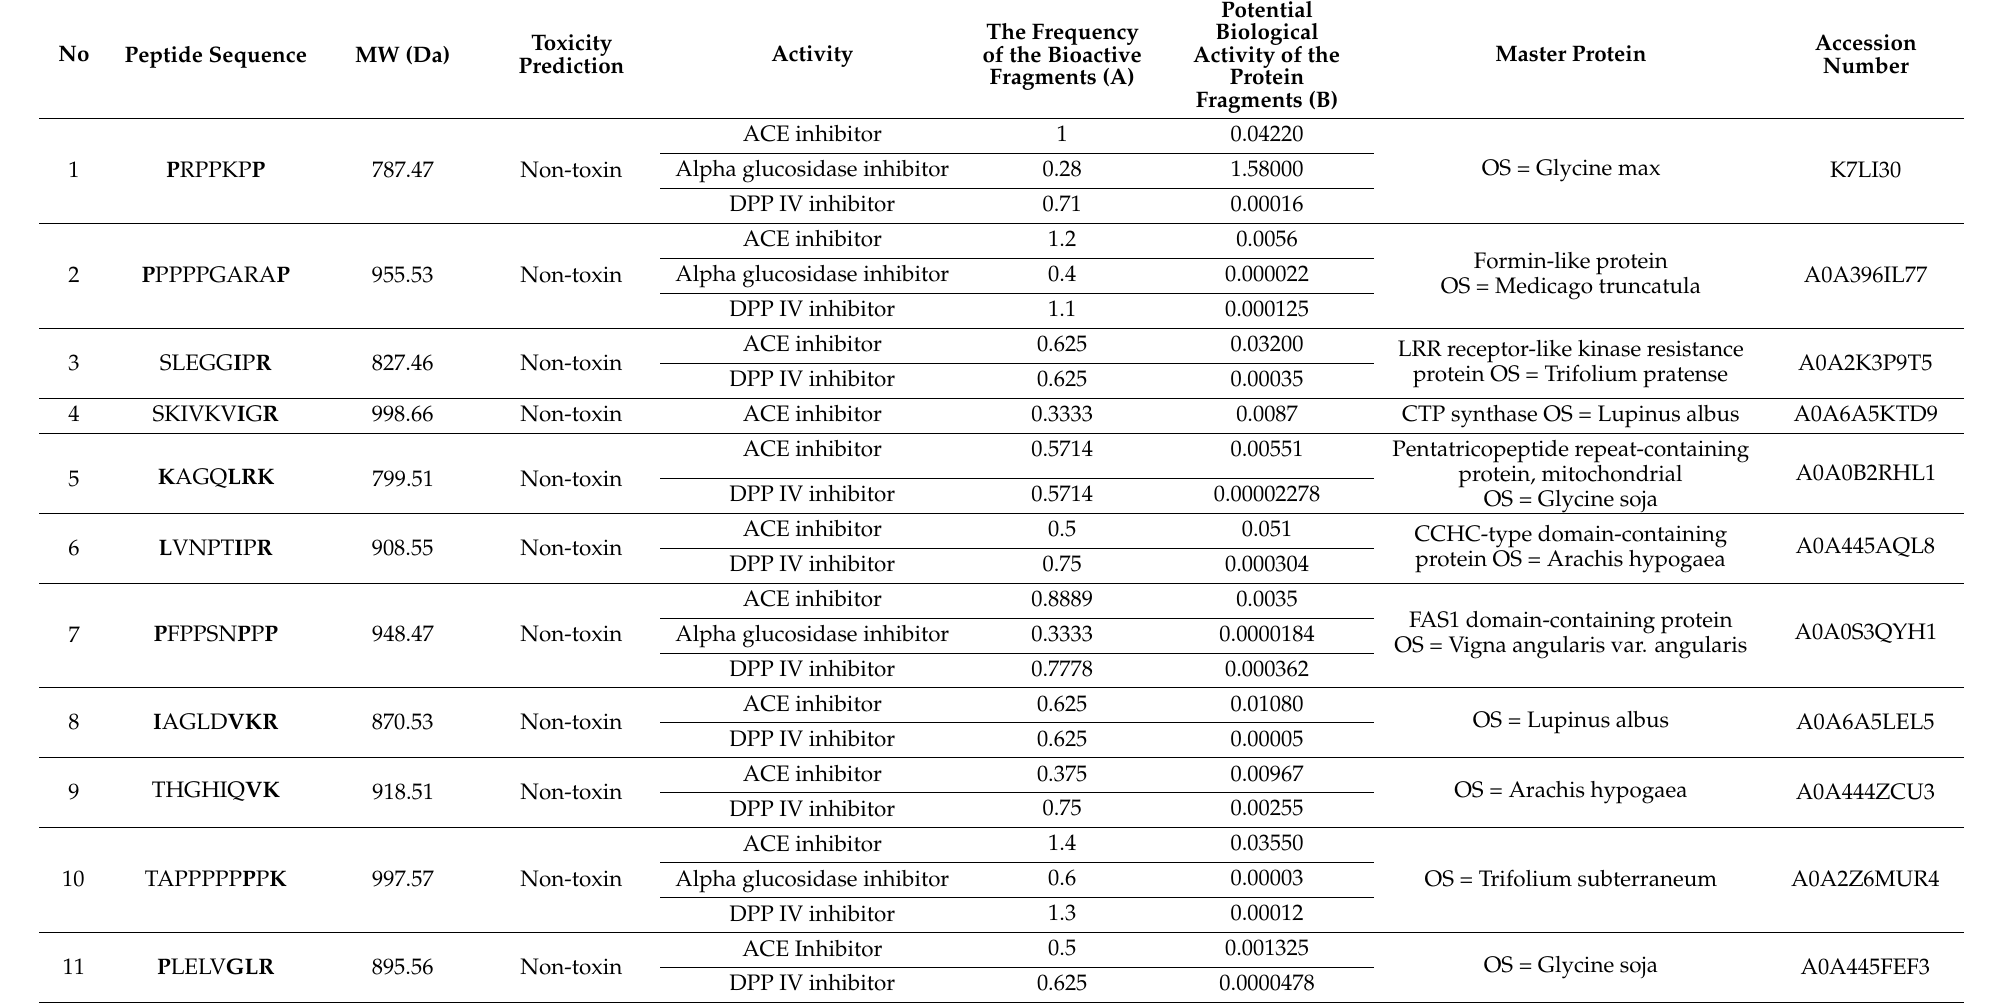
Table 2. Peptide sequence of the germinated lamtoro gung flour obtained from the GID simulation <1 kDa peptide